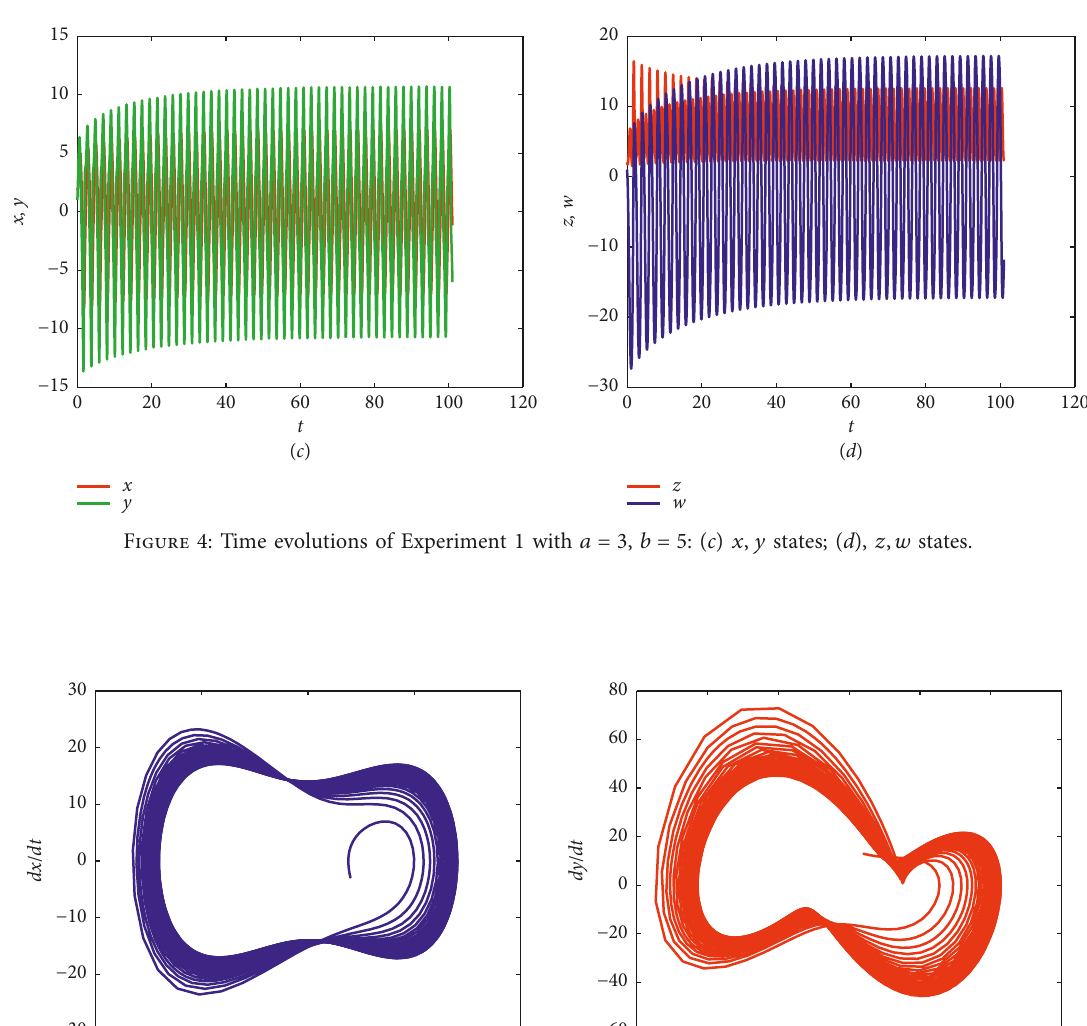
) phase diagram of x ; ( b 2